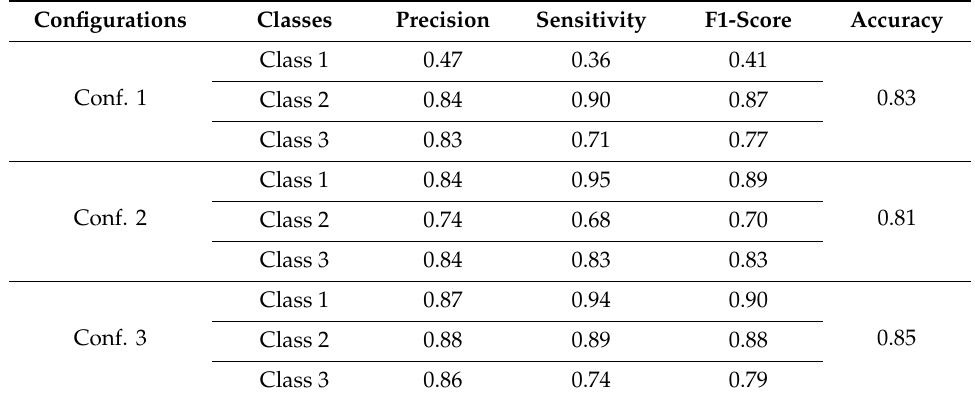
Table 7. The error performance (precision, sensitivity, F1-score, and accuracy) of the localized model KNN-LS-SVM model for the three di ff erent 3-class configurations based on leave-one-subject-out (LOSO) testing approach.